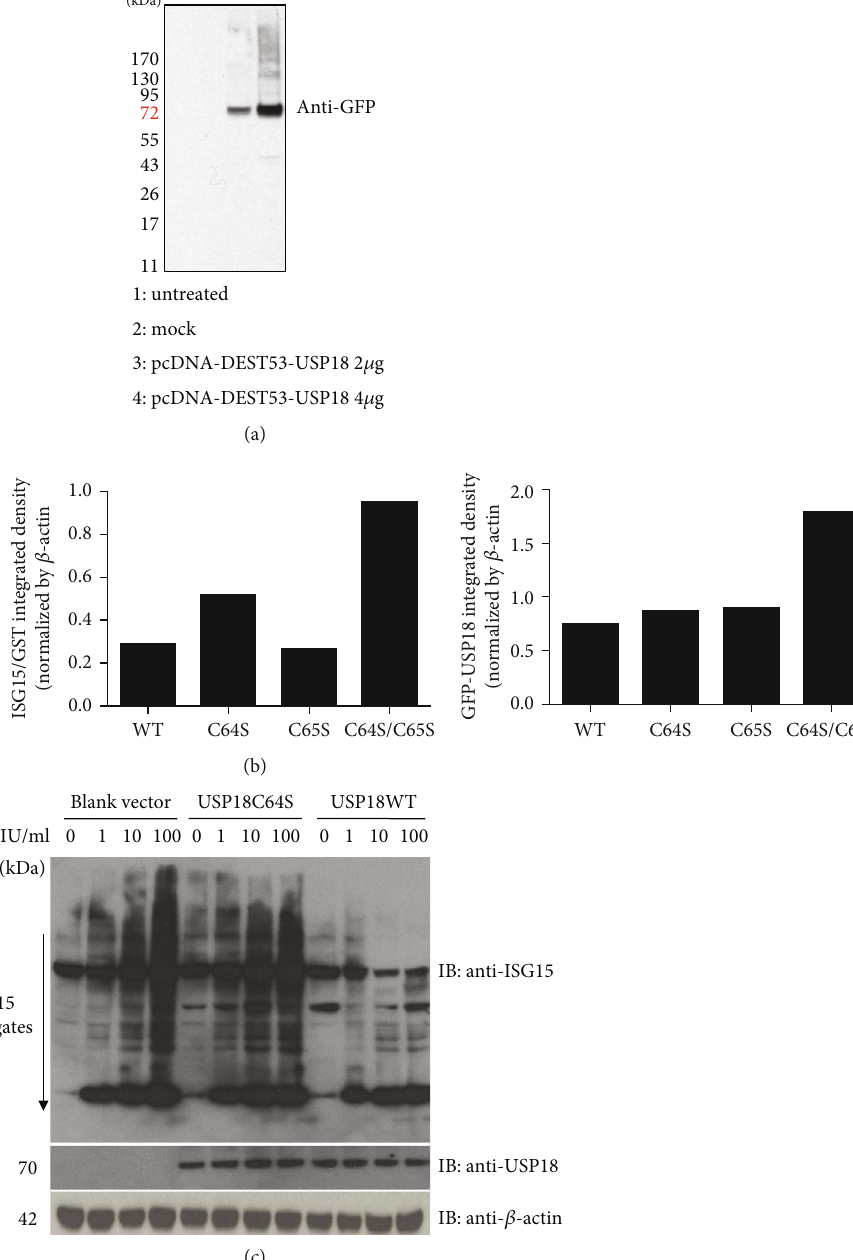
Figure 1: Human USP18 expression and catalytic activity in Huh7.5 cells. (a) Huh7.5 cells were seeded at 3 × 10 5 /ml , 2 ml per well in 6-well plates in antibiotic-free medium for 24 hours before 4 μ g empty vector pcDNA-DEST53, 2 μ g USP18 WT, or 4 μ g USP18 WT was transfected into each well. 48 hours posttransfection, total protein was extracted to detect GFP tag by western blot. (b) Cleavage of ISG15-GST fusion in vitro. Huh7.5 cells were transfected with various USP18 plasmids (wild-type USP18, WT; USP18 C64S, C64S; USP18 C65S, C65S; or USP18 C64/65S, C64/65S) in combination with ISG15-GST. 48 hours posttransfection, total protein was extracted to detect ISG15 and USP18 by western blot. (c) Cleavage of ISG15 conjugates in IFN α -treated Huh7.5 cells. Huh7.5 cells were transfected with an empty vector (vector), USP18 WT, or USP18 C64S. 24hrs later, the cells were treated with IFN α (0-100 U/ml) for 24 hours, after which western bot was performed to analyze expressions of ISG15 conjugates and USP18. Untreated: untreated control; mock: transfected with 4 μ g empty vector pcDNA-DEST53; pcDNA-DEST53-USP18: transfected with wild-type USP18 (USP18